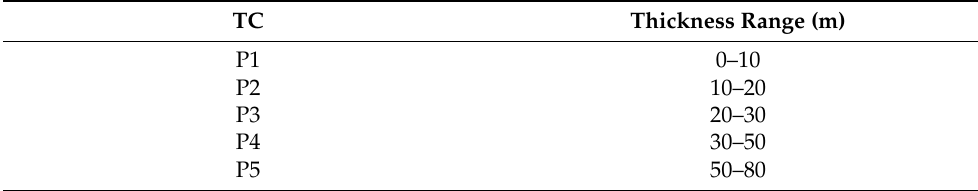
Table 3. Ranking of the Thickness Classes of the